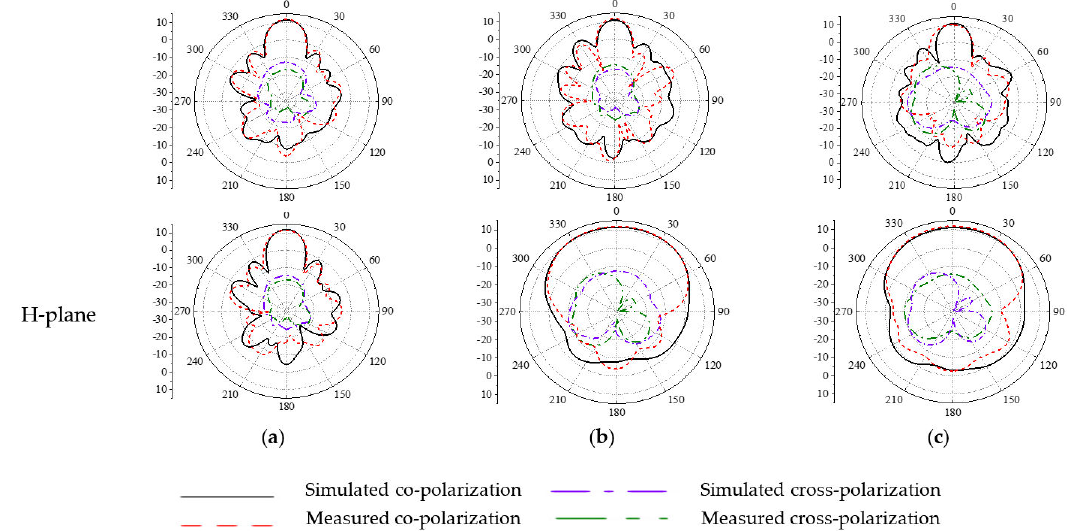
Figure 22. Measured and simulated radiation patterns of the proposed antenna array in the E-plane (top line) and H-plane (bottom) at ( a ) 9 GHz, ( b ) 10 GHz, and ( c ) 11 GHz.